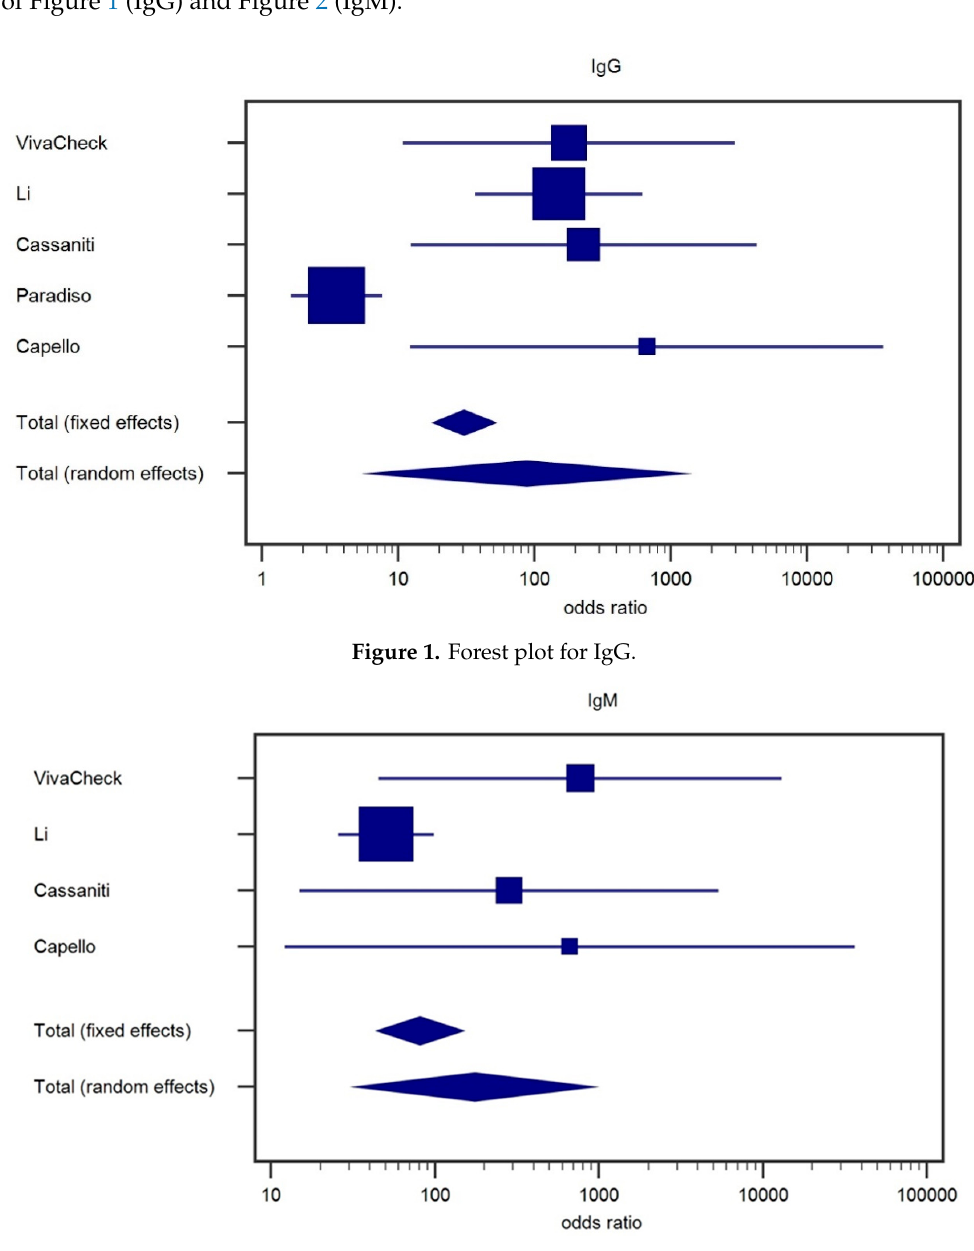
Figure 2. Forest plot for IgM.